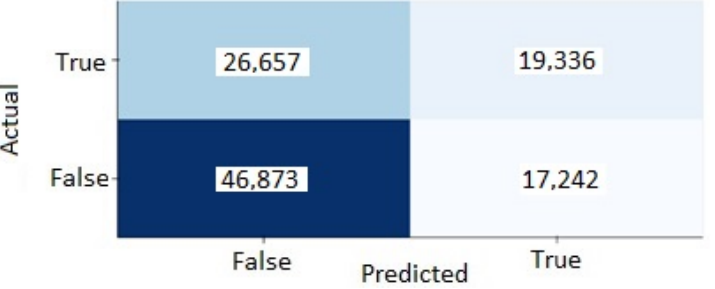
Figure 9. Confusion matrix of the fifth model.